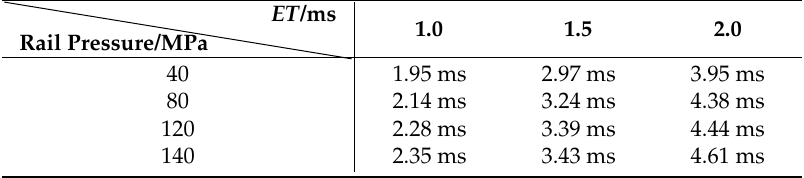
Table 3. Injector opening period variation with the rail pressure under different injection durations.